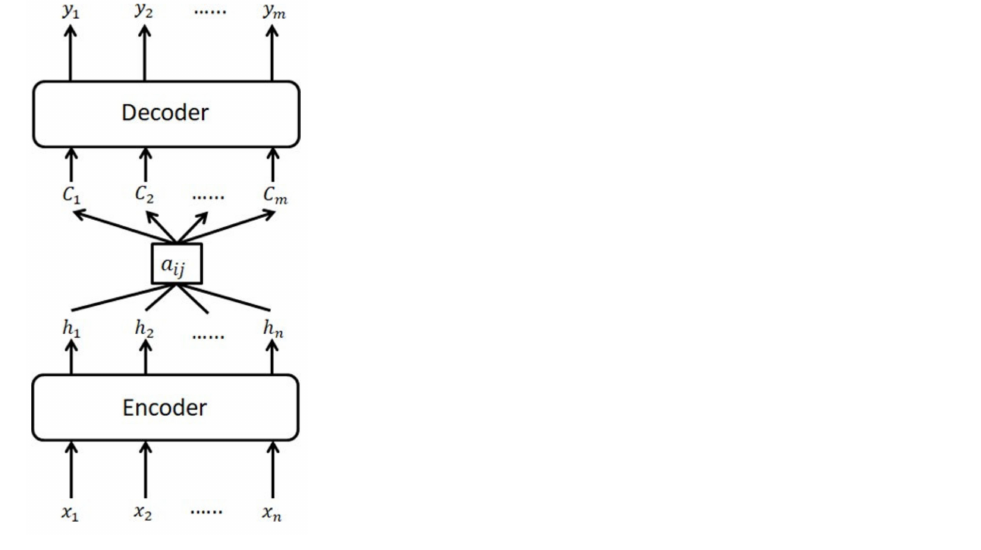
Figure 3. The framework of encoder–decoder based on attention